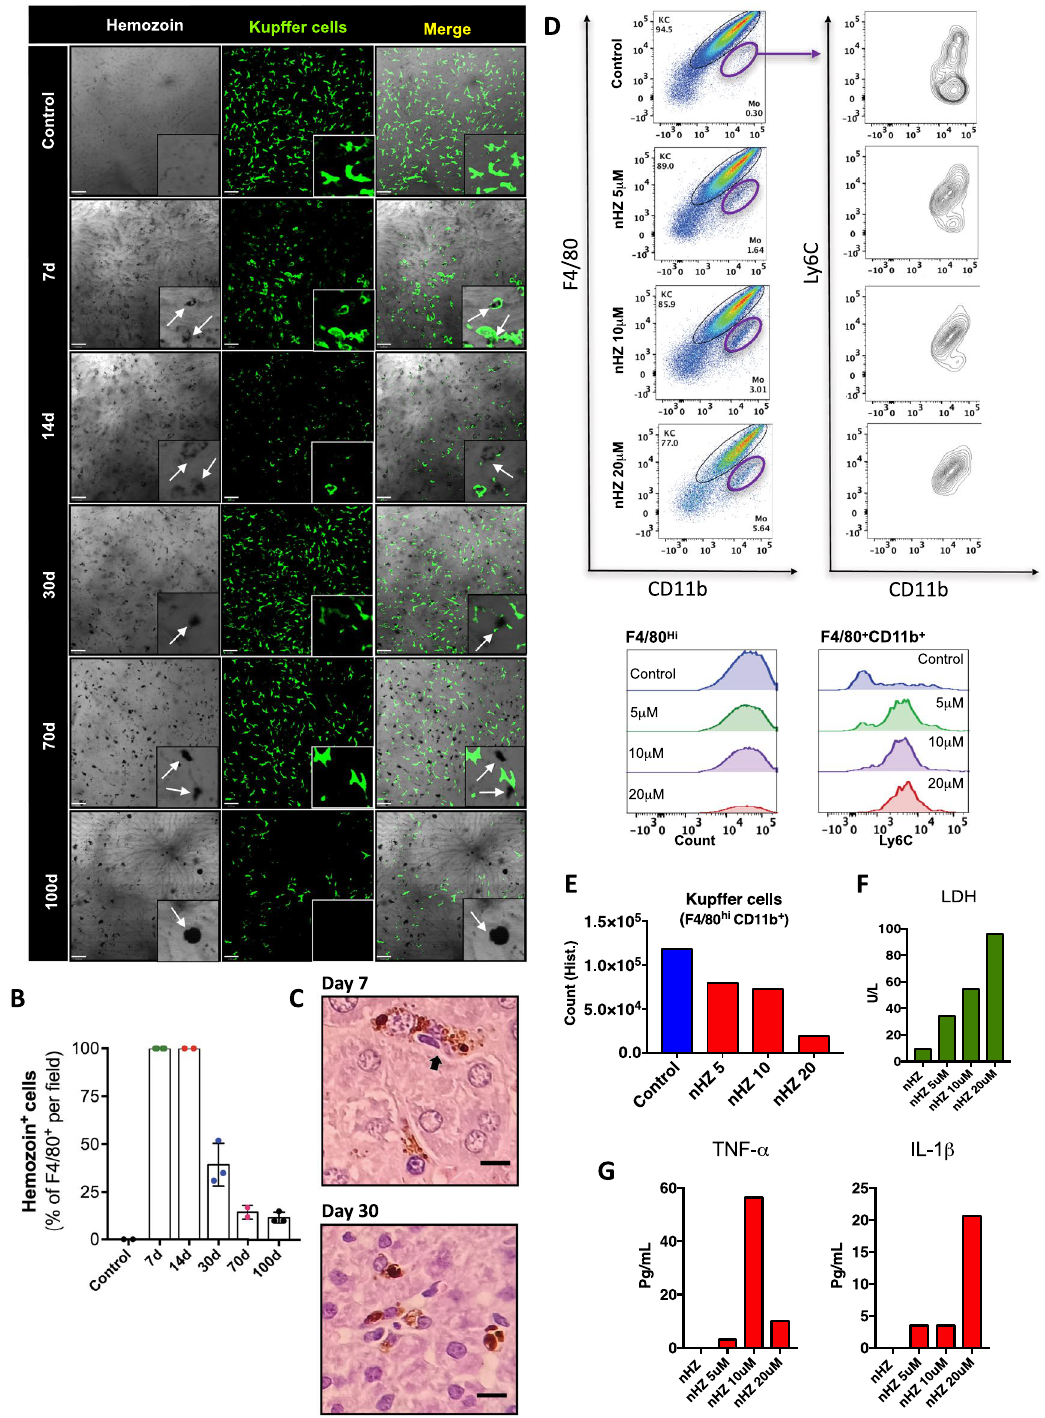
Figure 5. Hemozoin directly promotes cell death of Kupffer cells. ( A ) Intravital microscopy showing the expression and distribution of F4/80 + cells (anti-F4/80; green) and hemozoin crystal within the liver. ( B ) Digital quantification of F4/80 + cells with hemozoin crystal (n = 2–4). ( C ) Liver histopathology analysis of Kupffer cell carrying hemozoin at day 7 post infection (HE staining, Bar = 16 µm). ( D ) Spleen non-parenchymal cells isolated and cultured overnight with purified hemozoin crystals. ( E ) Absolute number of Kupffer cells, ( F ) LDH release and ( G ) TNF and IL-1β levels after overnight culture of Kupffer cells cultured with hemozoin crystals. The data shown are representative of 3 independent experiments. Data expressed as mean ±